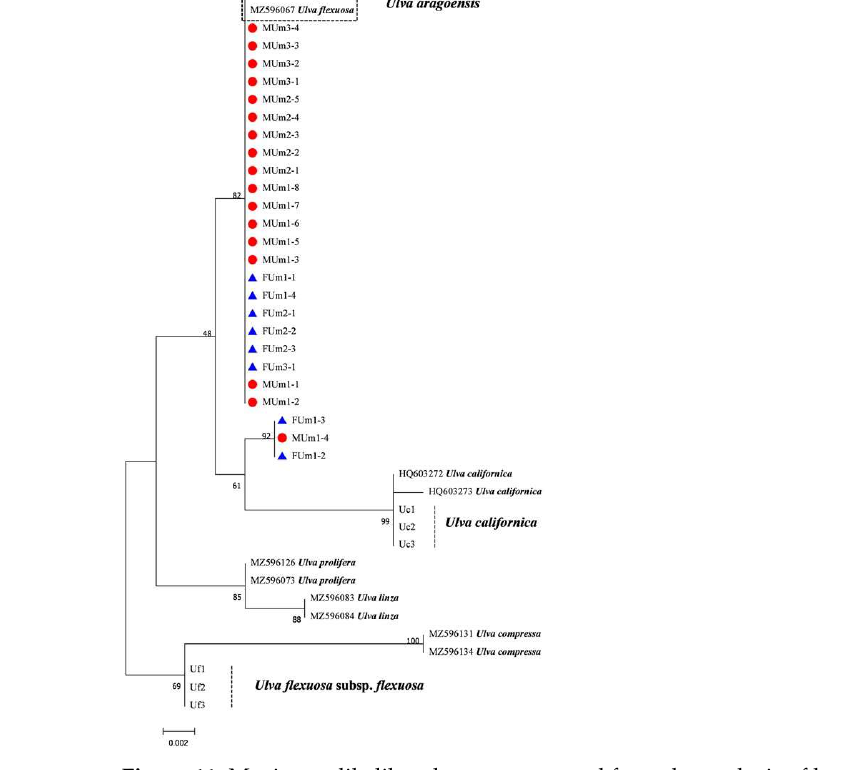
Figure 12. Maximum likelihood tree constructed from the analysis of rps2- trn L gene sequences of U. aragoensis samples and those downloaded from GenBank.